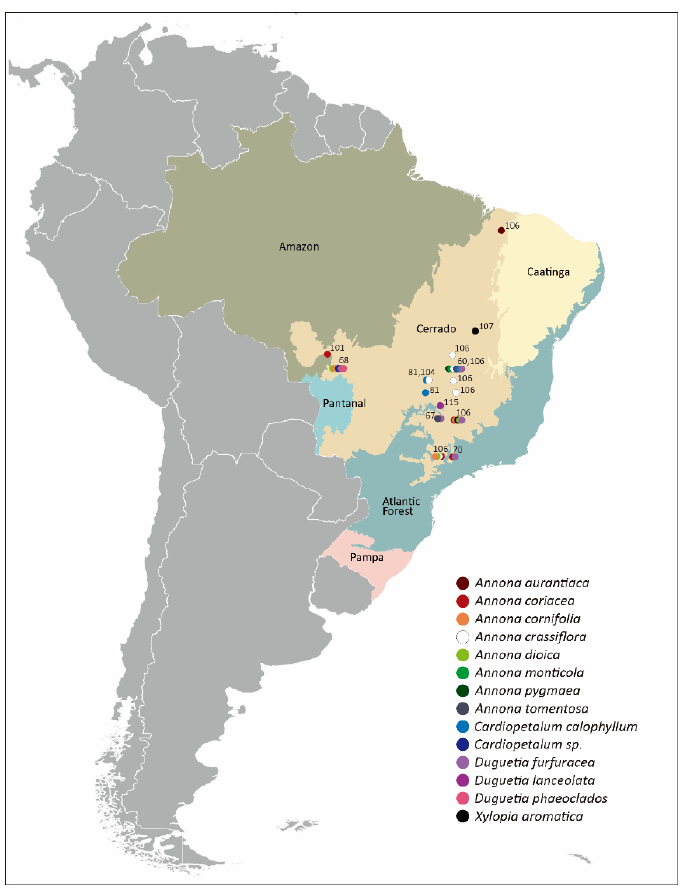
Figure 1. Brazilian biomes with Cerrado localities (circles) indicating Annonaceae study sites based on georeferenced published datasets. Circle colors refer to species, numbers to references cited. For further information, see Table 1.